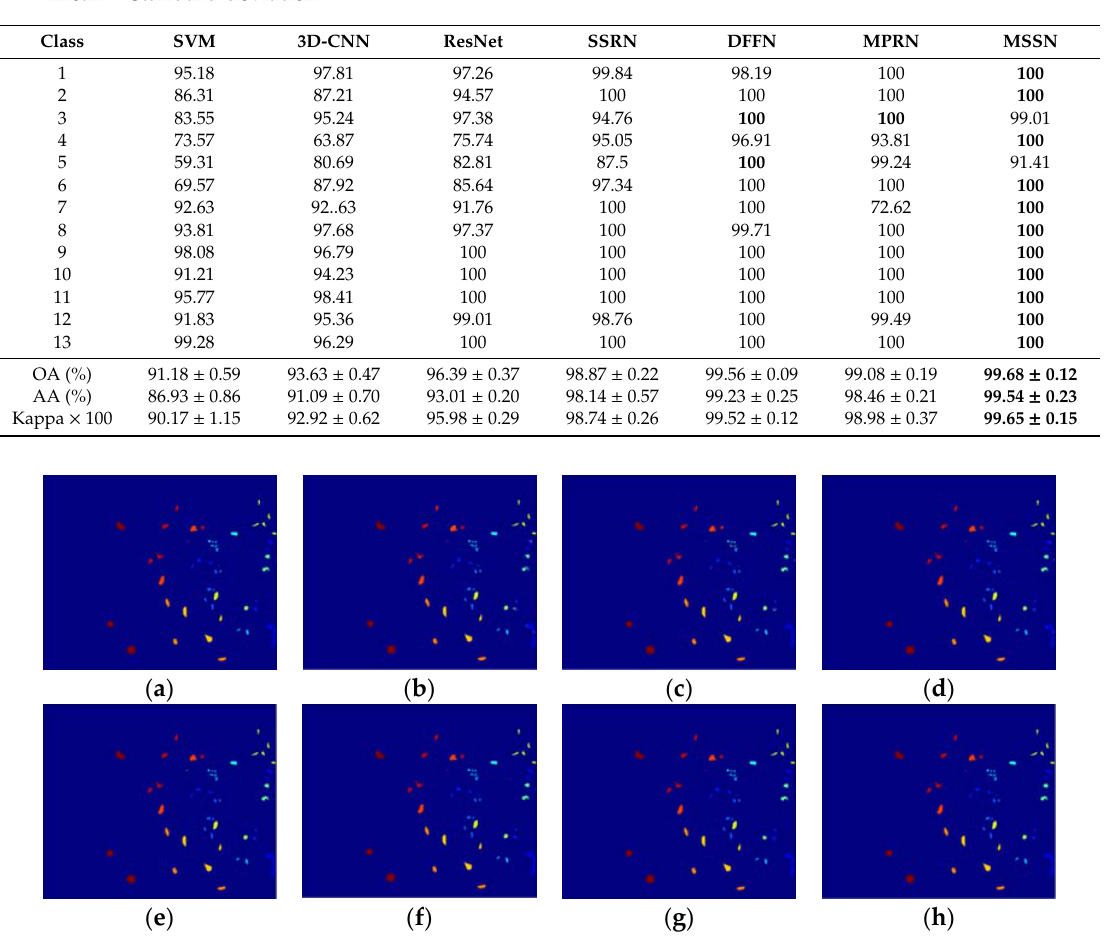
Figure 15. Classification maps for the KSC data set. ( a ) Ground truth. ( b ) SVM. ( c ) 3D-CNN. ( d ) ResNet. Figure 15. Classi fi cation maps for the KSC data set. ( a ) Ground truth. ( b ) SVM. ( c ) 3D ‐ CNN. ( d ) Remote Sens. 2020 , 12 , x FOR PEER REVIEW ( e ) SSRN. ( f ) DFFN. ( g ) MPRN. ( h ) MSSN. ResNet. ( e ) SSRN. ( f ) DFFN. ( g ) MPRN. ( h ) MSSN.